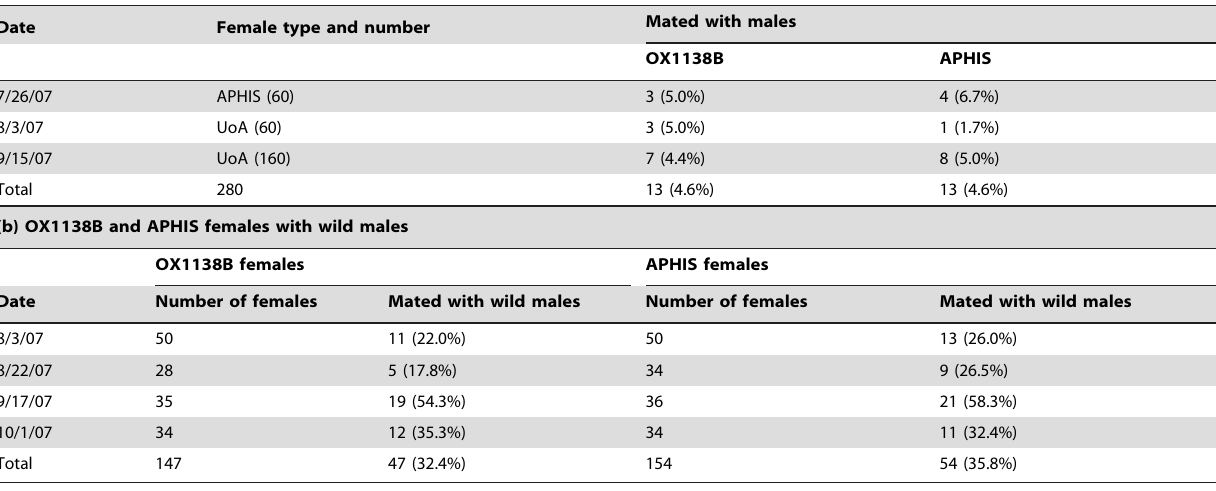
Table 1. Moth mating